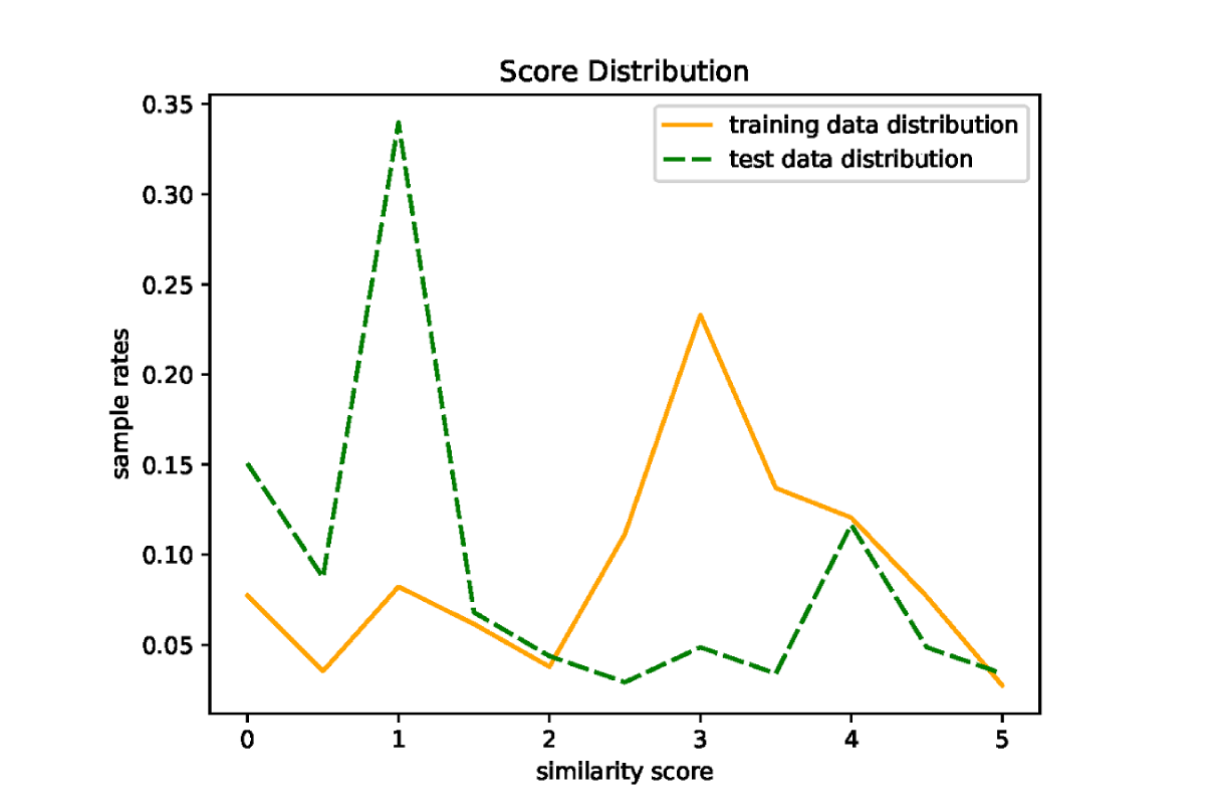
Figure 3. Similarity interval distribution in the training and test data